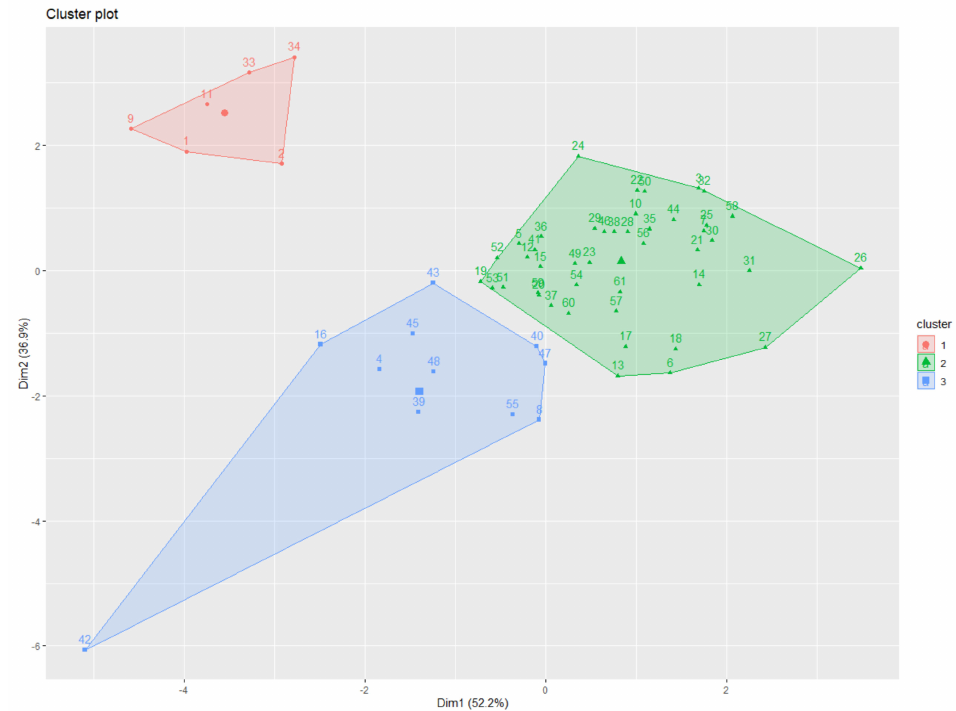
Figure 3. Visualization of the spatial relationships between adzuki bean accession clusters formed by plotting the first two dimensions. Dots with different colors indicate comparable accessions gathered together in a cluster. The results of K-means clustering (three clusters) using the first two principal component analysis dimensions are shown using different colors representing cluster